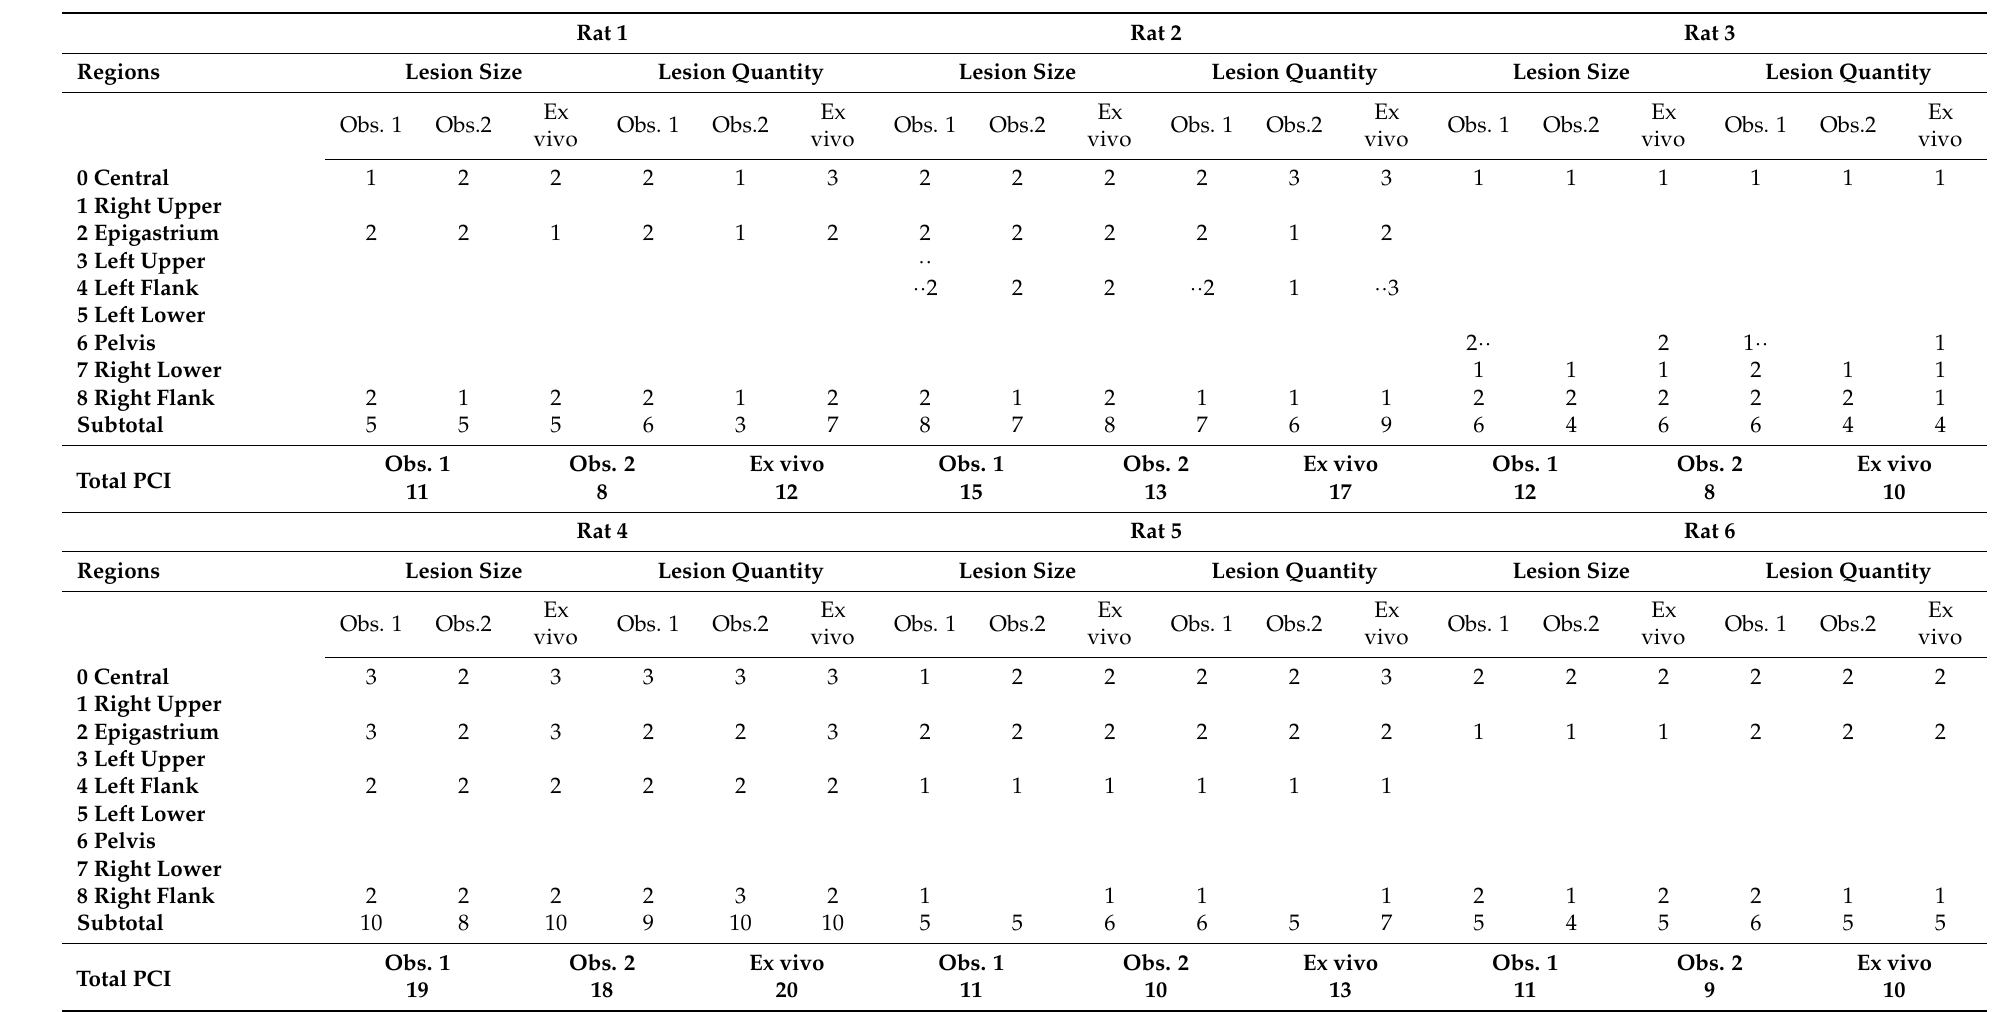
Table 1. Numerical details on the PCI